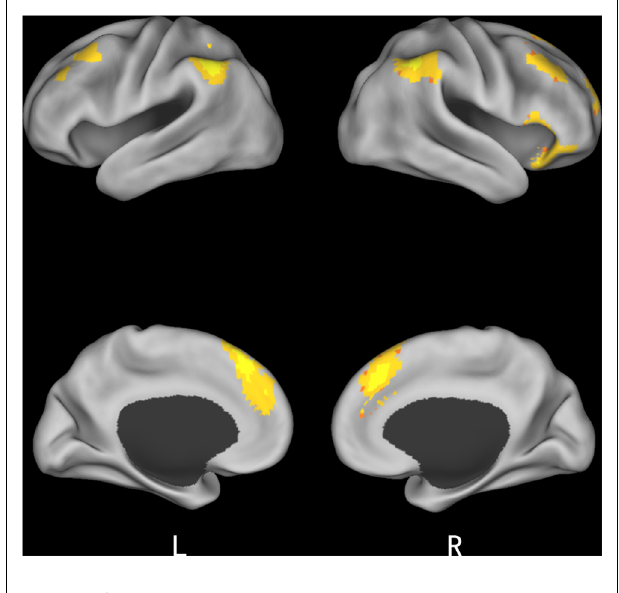
FIGURE 4 | Brain regions involved in conformity effect.